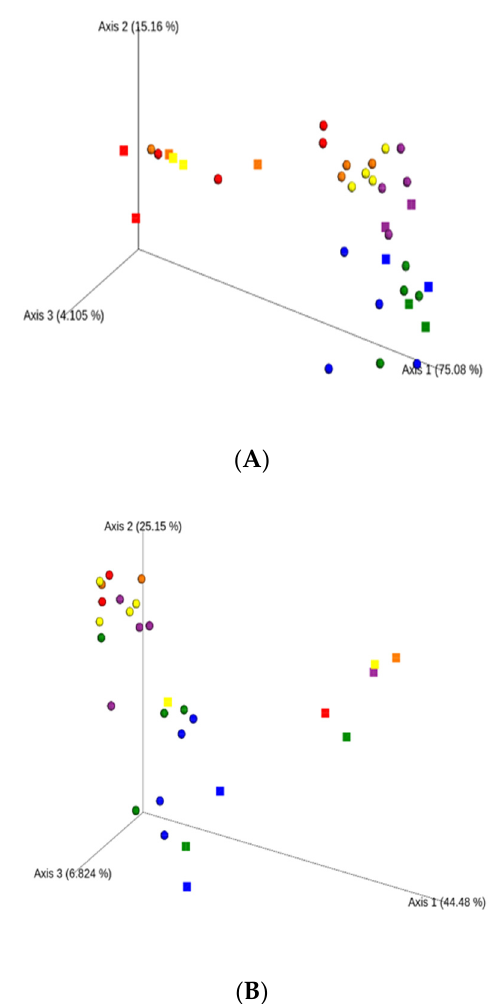
Figure 4. Principal coordinate analysis of Weighted UniFrac distances for bacterial community ( A ) and Bray-Curtis distances for fungi community ( B ) in the fermentation processes. Symbols represent the wine: Trebbiano (squares) and Montepulciano (circles). Different colors represent the different sampling time: Day 1 (green). Day 3 (blue). Day 6 (purple). Day 9 (yellow). Day 15 (orange) and the end of fermentation Day 30 (red). For interpretation of the references to color in this figure legend, the reader is referred to the web version of this article.